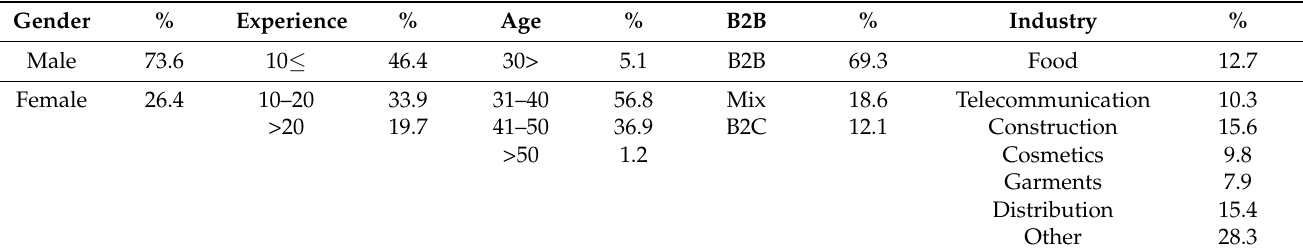
Table 1. Characteristics of the sample.